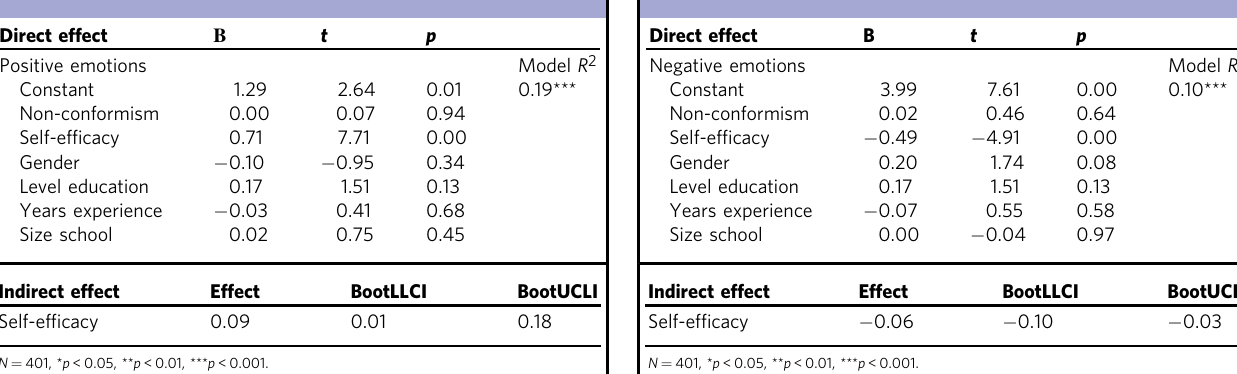
Table 3 Direct and indirect effects of self-ef fi cacy on positive emotions.